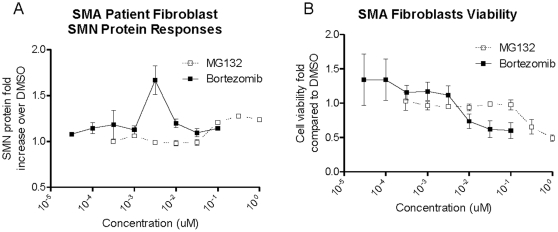
Detection of SMN protein dose-response in SMA fibroblasts.SMA Type I fibroblasts (line GM03813) were treated for 24 h with the proteasome inhibitors MG132 or bortezomib (N = 2 each). A: A peak SMN protein upregulation of 27% was observed with 0.3 µM of MG132 (EC50 = 0.68 uM) and a 67% increase was seen with 3 nM bortezomib (EC50 = 10 nM). B: Cell viability as measured by ATP levels (CellTiter-Glo, Promega) decreased to 50–75% at doses near and above doses that increased SMN protein levels. Error bars represent standard deviations.